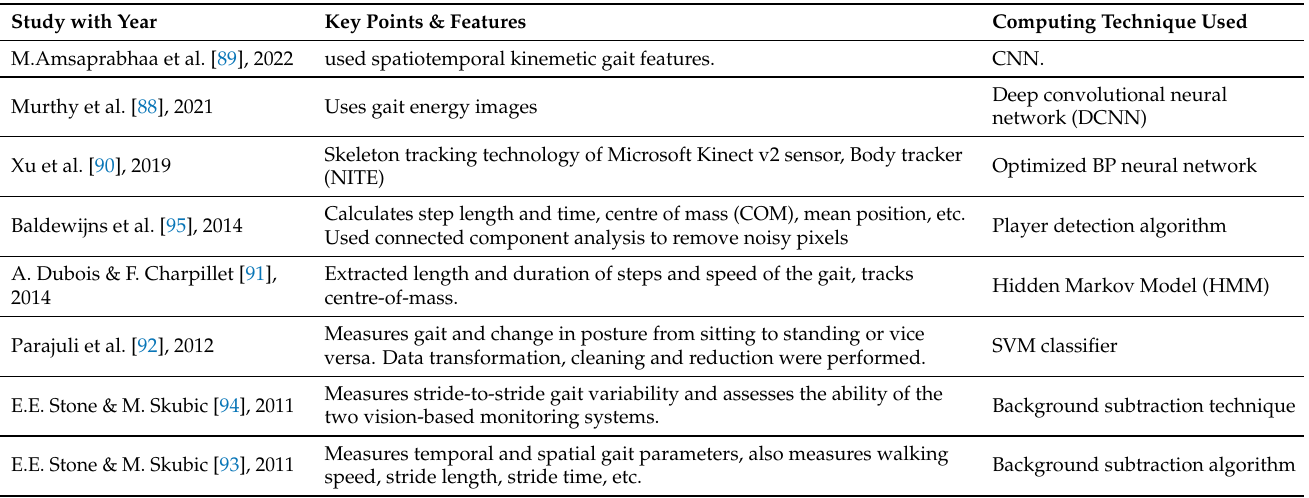
Table 2. Overview of fall detection using depth imagery with gait parameter from the last